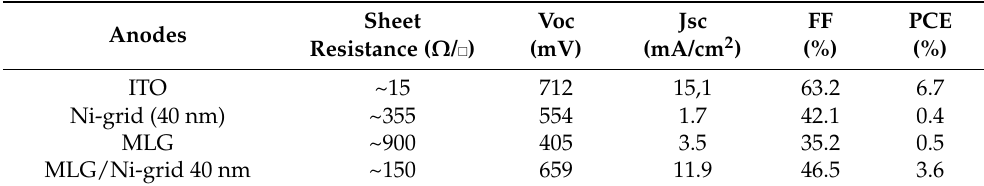
Figure 6. J-V characteristics of the bulk heterojunction solar cells on two different anodes: ITO/glass, and Graphene/Ni-grid 40 nm/quartz for direct ( a ) and inverted ( c ) architecture. IPCE spectrum for direct ( b ) and inverted ( d ) OSCs. The right-hand axis indicates the integrated photocurrent that is expected to be generated under AM 1.5G irradiation on two different anodes: ITO/glass and Graphene/Ni-grid/quartz. Table 2. Photovoltaic parameters of BHJ solar cells in inverted configuration on glass-ITO (reference), graphene/Ni-grid with different thicknesses as cathode, fabricated in the same batch with 0.1 cm 2 of active